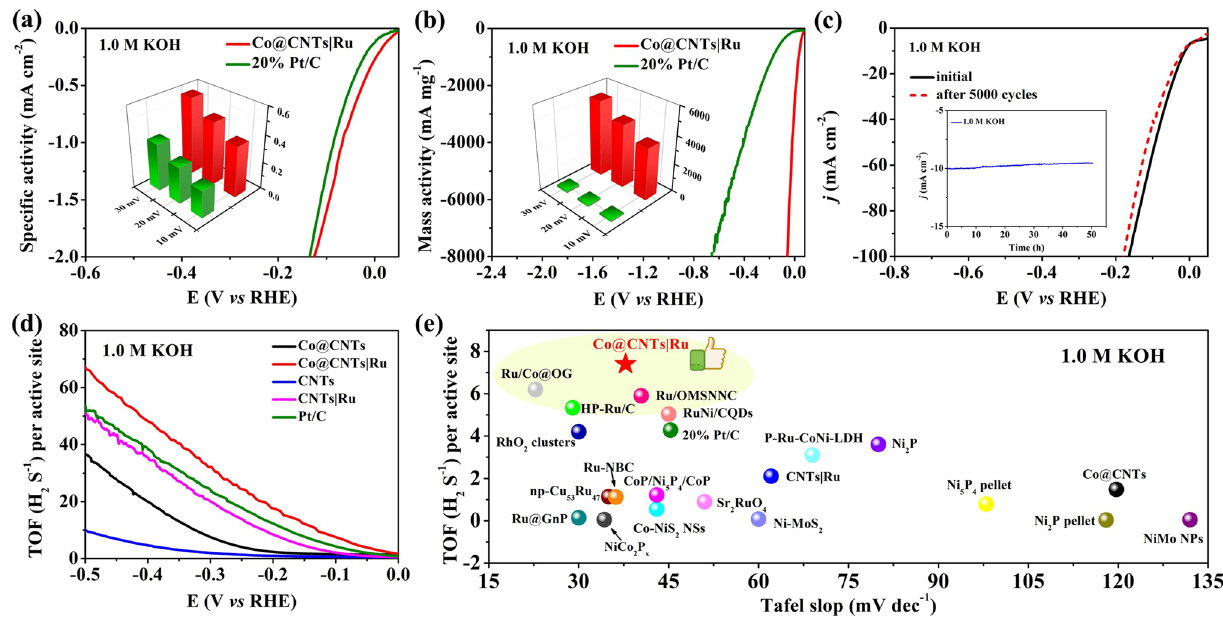
Fig. 4 a Specific activities and b mass activities of Co@CNTs|Ru and Pt/C (Intet: specific activities (inset in a ) and mass activities (inset in b ) at different overpotentials of 10, 20, and 30 mV); c LSV curves for Co@CNTs|Ru before and after 5000 cycles of CV test (Inset: the i-t curves of Co@CNTs|Ru for 50 h); d TOF per surface metal site of Co@CNTs, Co@CNTs|Ru, CNTs, CNTs|Ru and Pt/C catalysts in 1.0 M KOH; e Comparison of TOF values and Tafel values of Co@CNTs|Ru, 20 wt% Pt/C catalyst and other recently reported HER electrocatalysts under the overpotential of 100 mV in 1.0 M